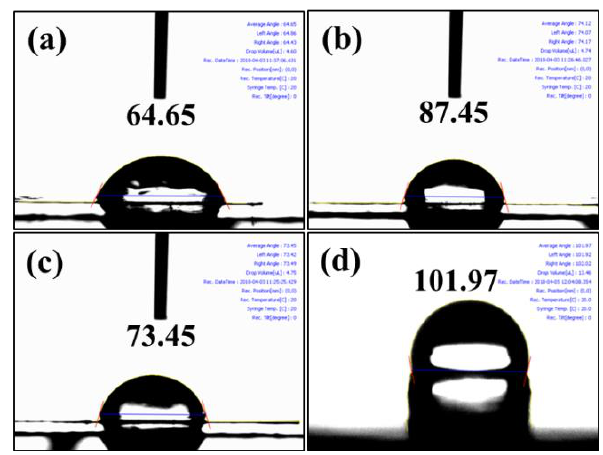
Figure 6. Water contact angle images of ( a ) X; ( b ) XY; ( c ) XYX; and ( d ) YXY.